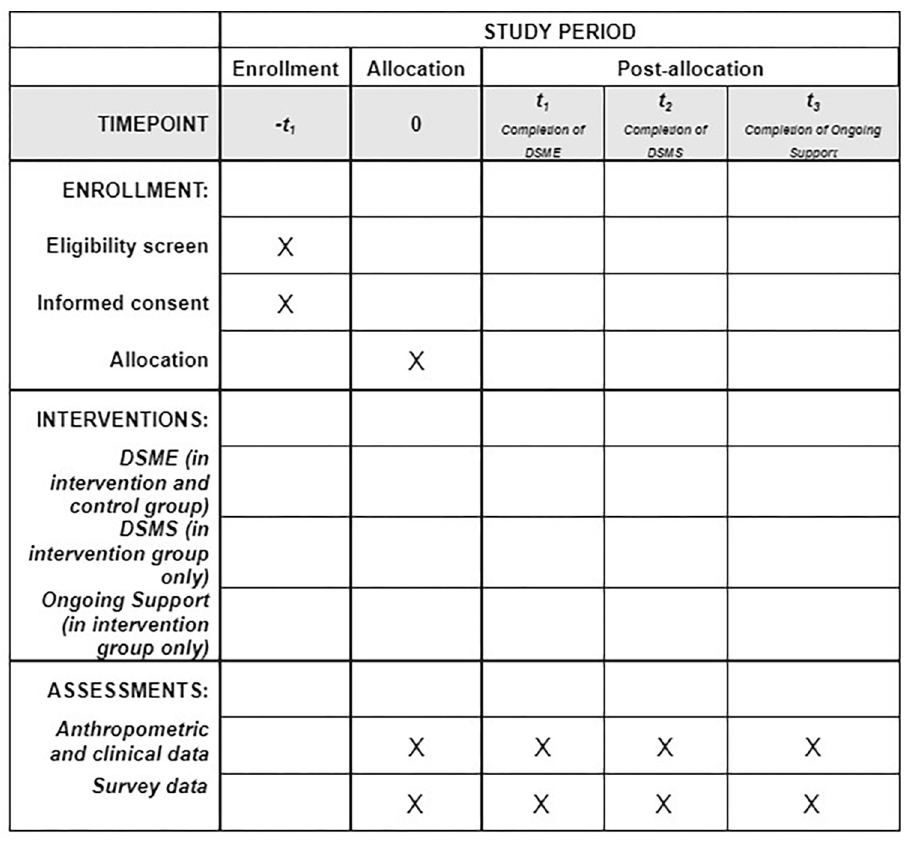
Fig 1. RCT enrollment, intervention, and